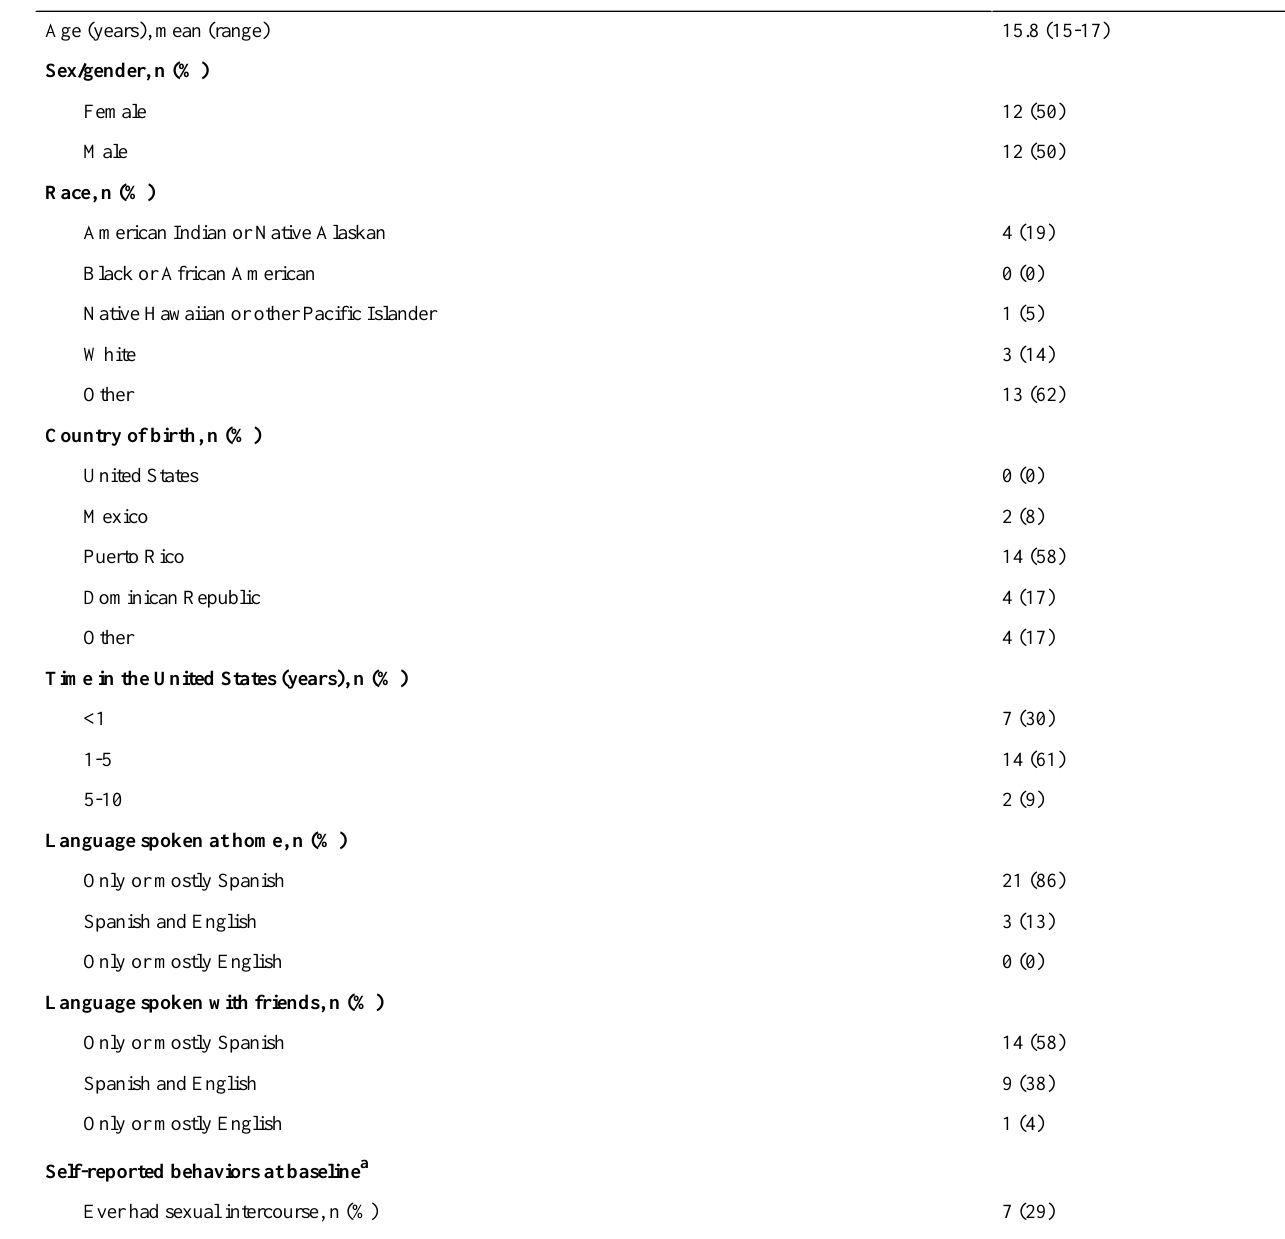
Table 1. Phase 2 baseline characteristics (N=24).